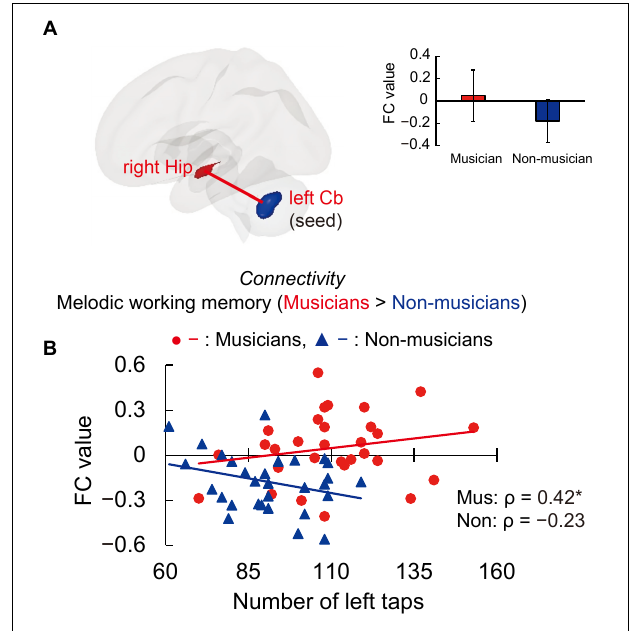
FIGURE 4 | Task-related FC. (A) Using ROIs in both sides of the cerebellum as the seed (where musicians showed greater GMV than non-musicians, as illustrated in Figure 3 ), musicians exhibited enhanced FC between the left cerebellum and right hippocampus during the MWM task compared to non-musicians, but no change in FC of the right cerebellum and other regions. (B) In the associations between cerebellar-hippocampal FC and behavioral functions, task-related cerebellar-hippocampal FC and left tapping speed were positively correlated in musicians. * P < 0.05, Mus, musicians; Non, non-musicians; FC, functional connectivity; ROI, region of interest; GMV, gray matter volume; MWM, melodic working memory; Hip, hippocampus; Cb,